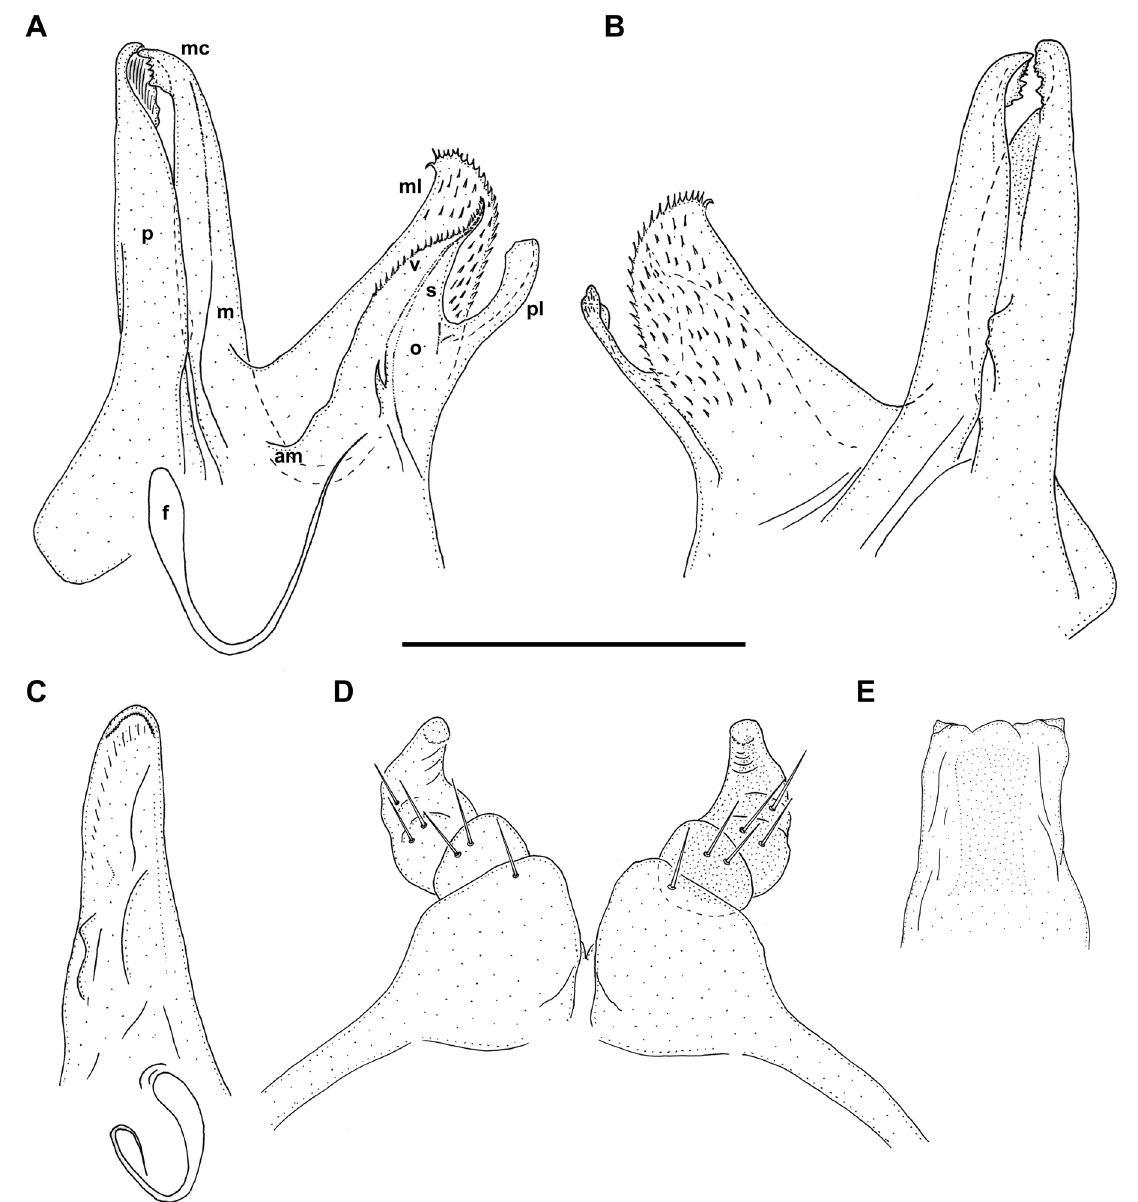
Fig. 51. Martvilia parva gen. et sp. nov., type ♂♂ (ZMUM). A . Holotype, left gonopods, mesal view. B . Holotype, left gonopods, lateral view. C . Paratype, right promere, posteromesal view. D . Paratype, leg-pair 1, anterior view. E . Paratype, penes, posterior view. Abbreviations: am = accessory membrane; f = flagellum; m = mesomere; mc = mesomeral claw; ml = mesomeral lamella; o = opisthomere; p = promere; pl = protective lamella; s = solenomere; v = velum. Scale bar: 0.3